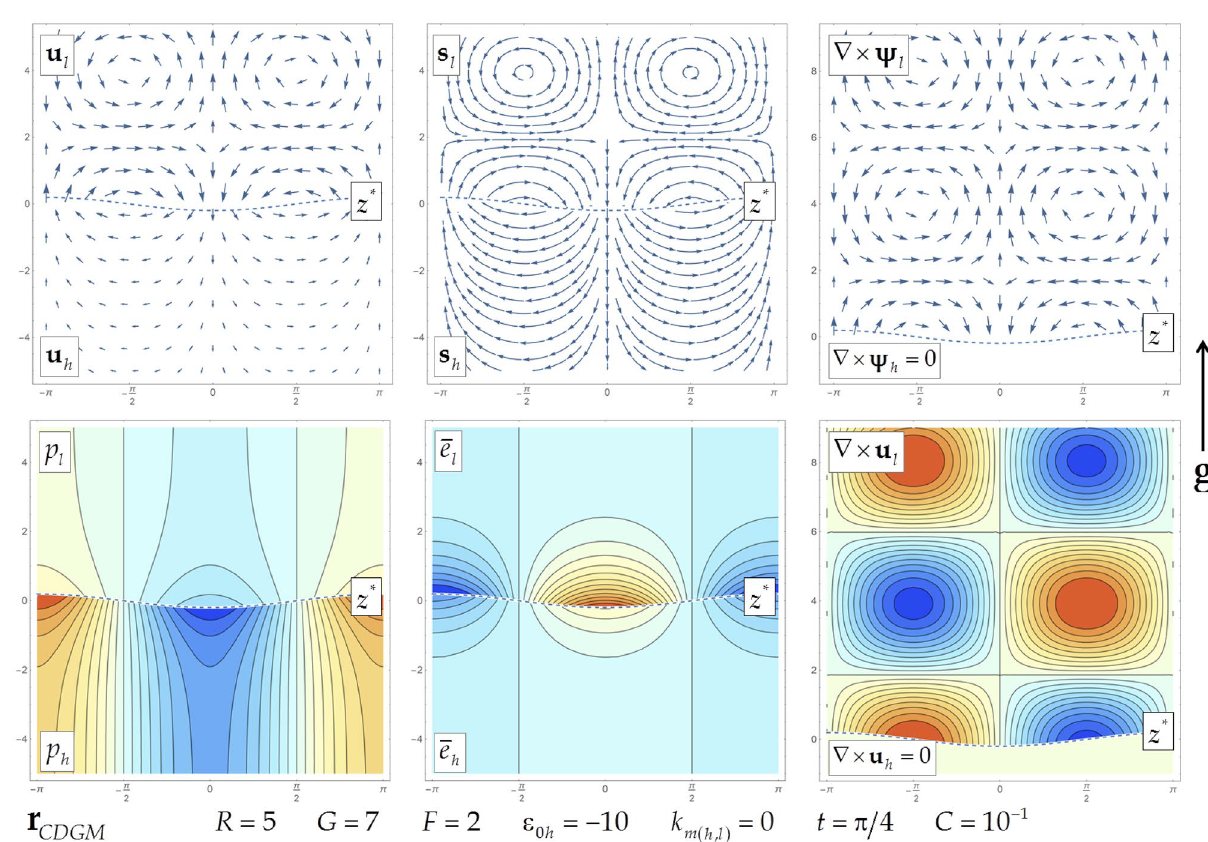
Fig. 4 Flow fields for stable accelerated low Mach dynamics: plots of real parts of perturbed fields of the interface, velocity, velocity stream- lines, pressure, vorticity, internal energy, with red (blue) for positive (negative) in contour